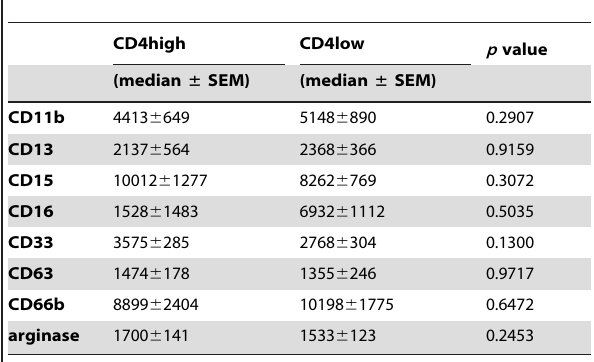
LDGs were isolated from the blood of HIV + patients with CD4 + T cell counts . 350 cells/ m L (n=11) or , 350 cells/ m L (n=10) as described in materials and methods and the expression levels of phenotypic markers were determined by flow cytometry.